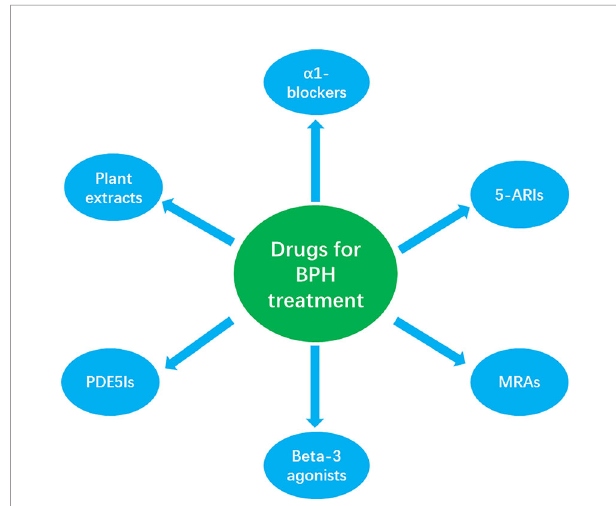
FIGURE 1 | The classi fi cation of the most common drugs used for the clinical treatment of LUTS/BPH, showing a 1-blockers ( a 1 adrenergic antagonists), 5 a -reductase inhibitors (5-ARIs), muscarinic receptor antagonists (MRAS), b 3-adrenoceptor agonists (beta-3 agonists), and phosphodiesterase 5 inhibitors